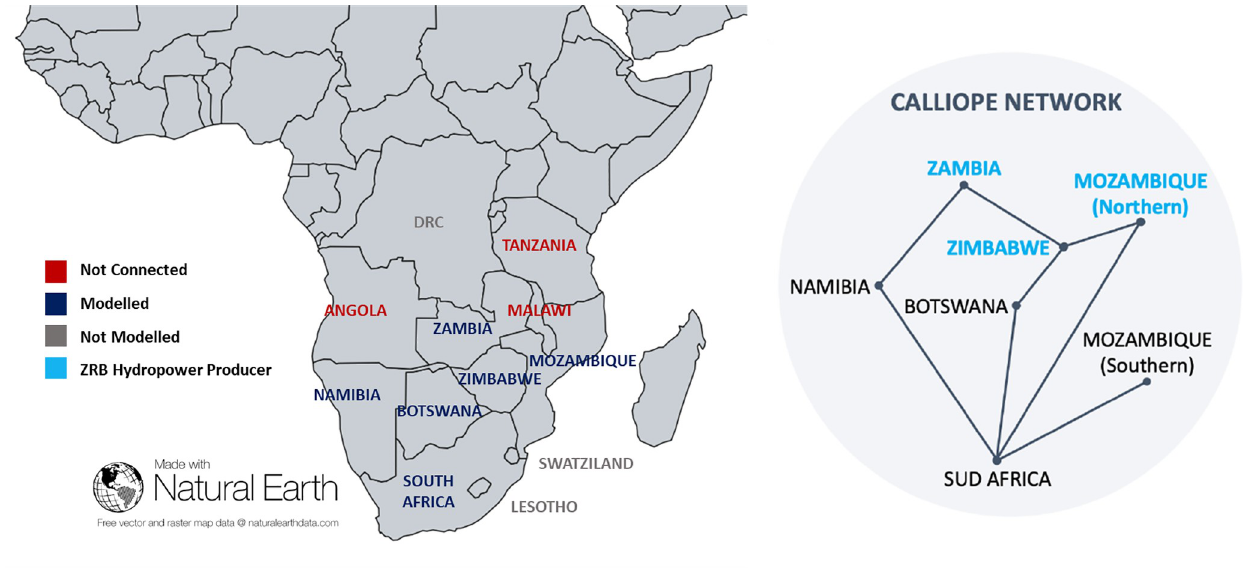
Fig 4. Southern Africa Power Pool (SAPP) countries and modelled network. Countries excluded from the analysis are highlighted in red, while countries part of the Zambesi River Basin (ZRB) are highlighted in light blue. Made with Natural Earth. https://doi.org/10.1371/journal.pone.0259876.g004 PLOS ONE | https://doi.org/10.1371/journal.pone.0259876 December2,